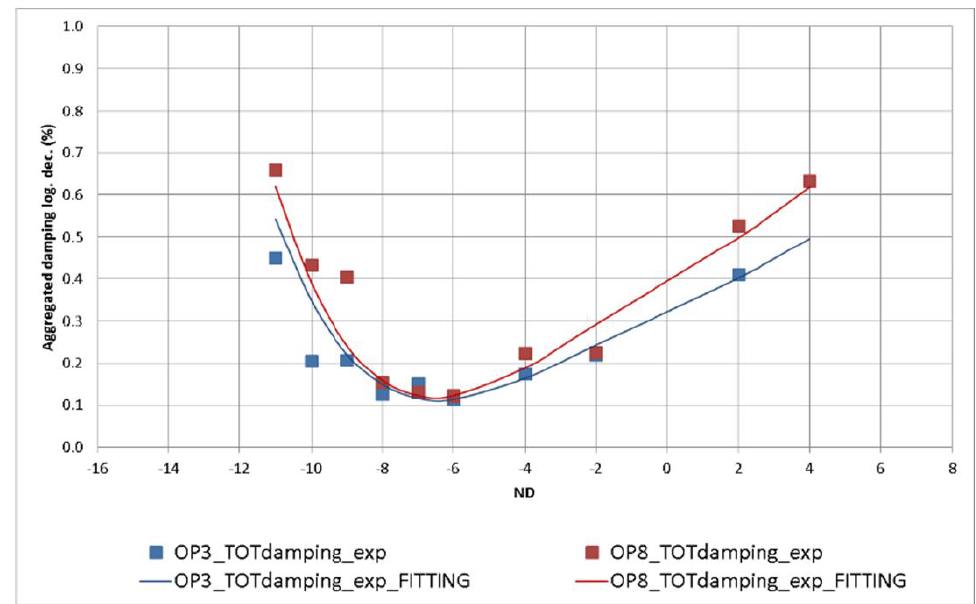
Figure 11. Aggregated damping of LSB for the first mode shape, in OP3 and